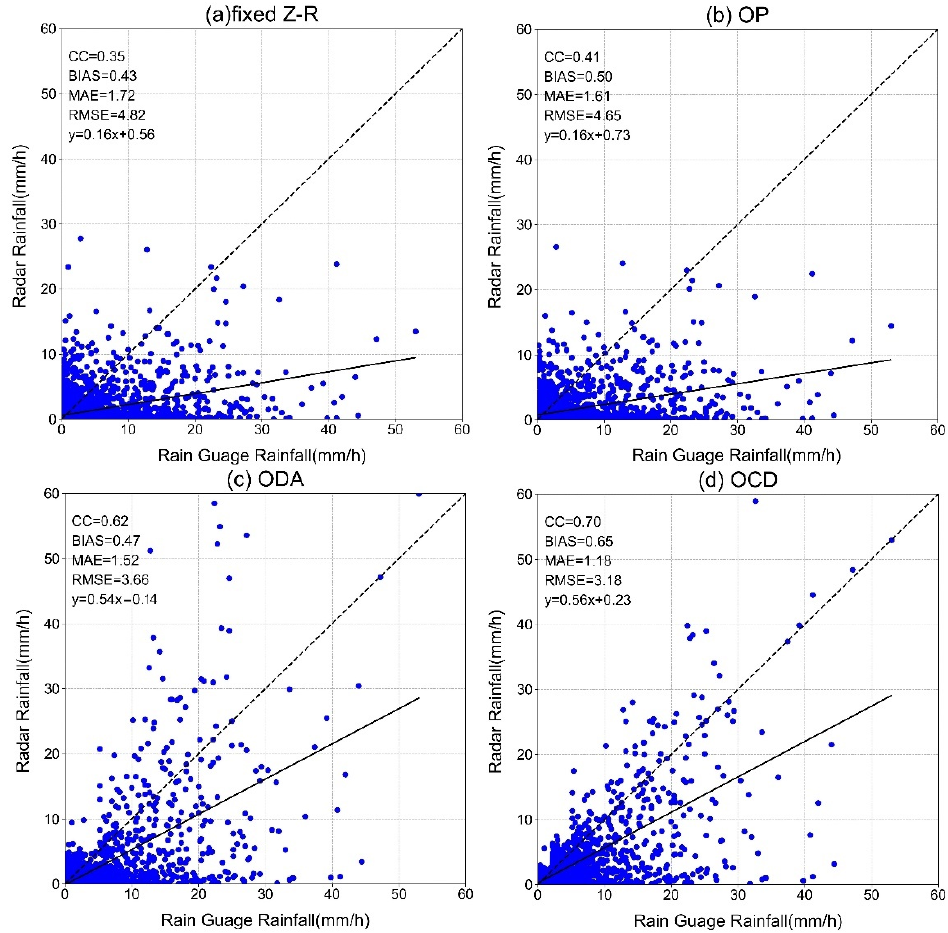
Figure 3. Scatter distribution of Rain Gauge Rainfall and different QPE algorithms, ( a ) fixed Z-R, ( b ) OP, ( c ) ODA and ( d ) OCD.